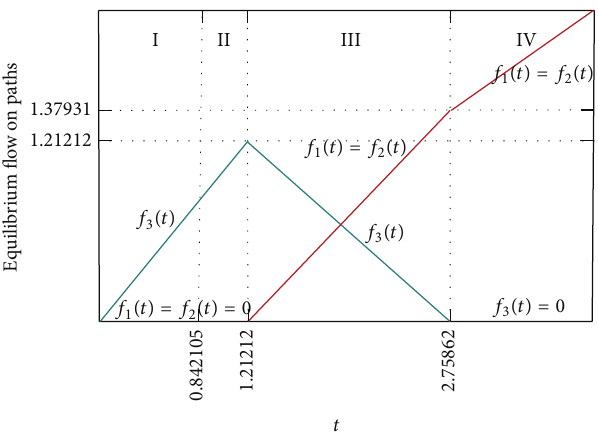
Figure 3: The equilibrium flow of the dynamic